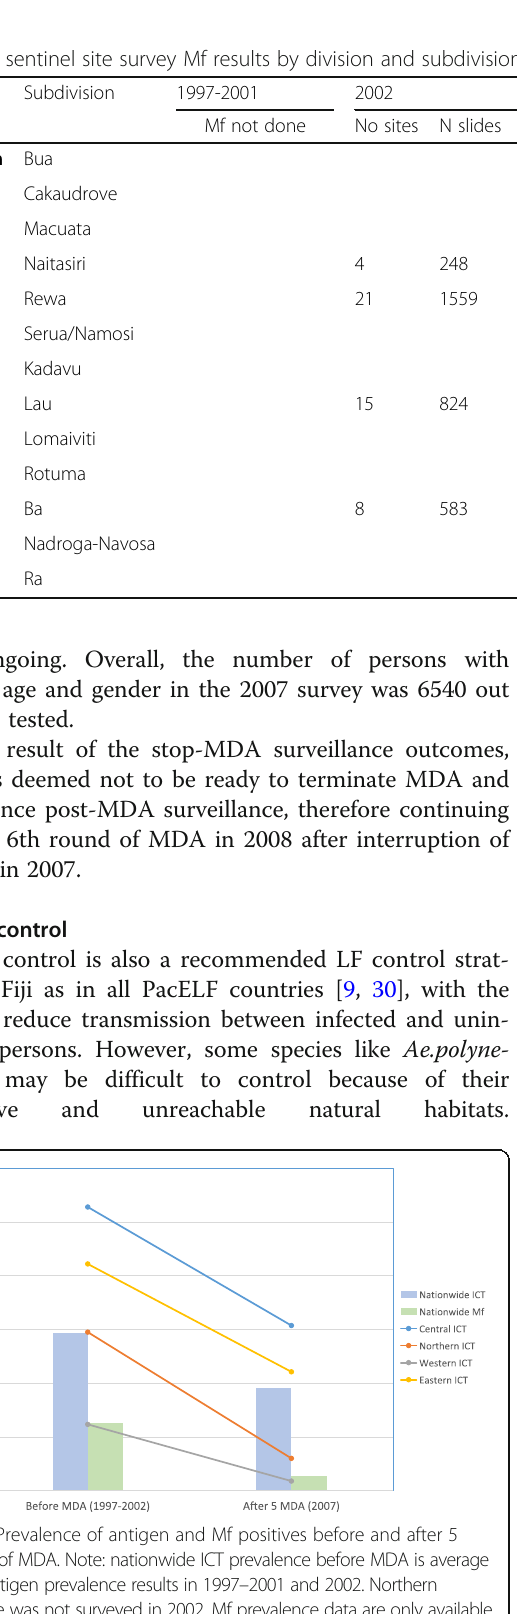
Fig. 3 Age- and gender-specific prevalence of antigen in 1997 – 2001 A survey and 2007 C